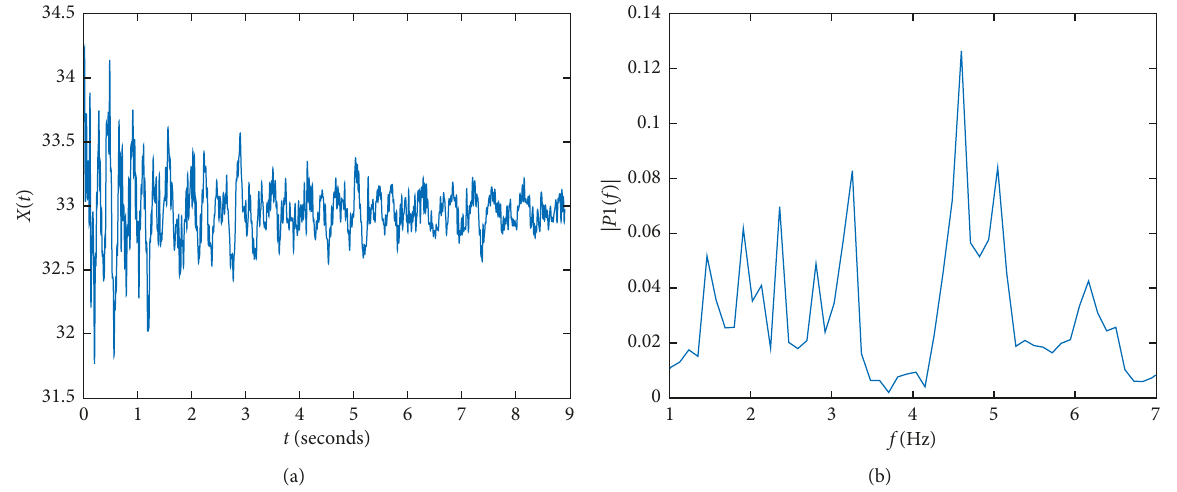
Figure 3: Measured acceleration and FFT when the vehicle left: (a) time history and (b) FFT of the accelerometer